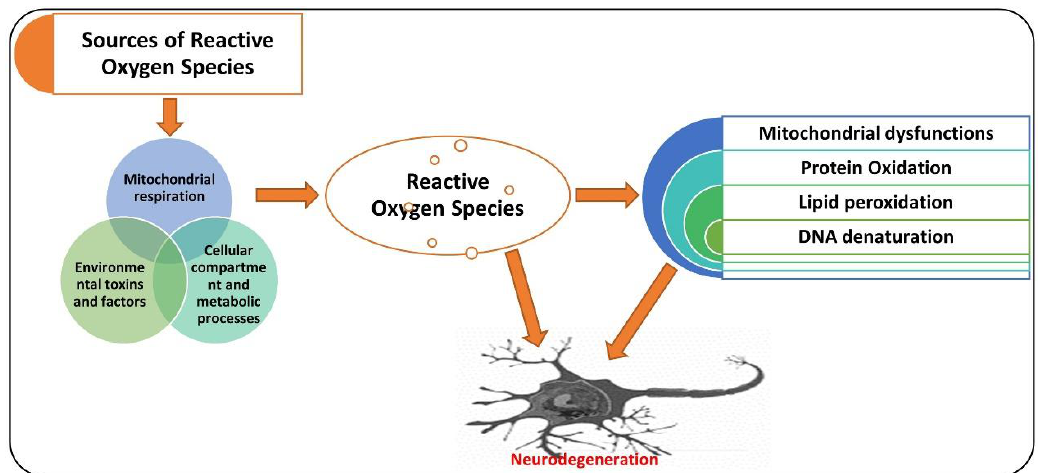
Figure 1. A simple illustration showing the role of reactive oxygen species (ROS) in neurodegenerative diseases. ROS may be produced from different sources, causing the mitochondrial dysfunction, oxidation of proteins, lipid peroxidation, and DNA denaturation, leading to neurodegeneration. The red arrow shows the processing. Red pointing arrow is showing the inducing effects.